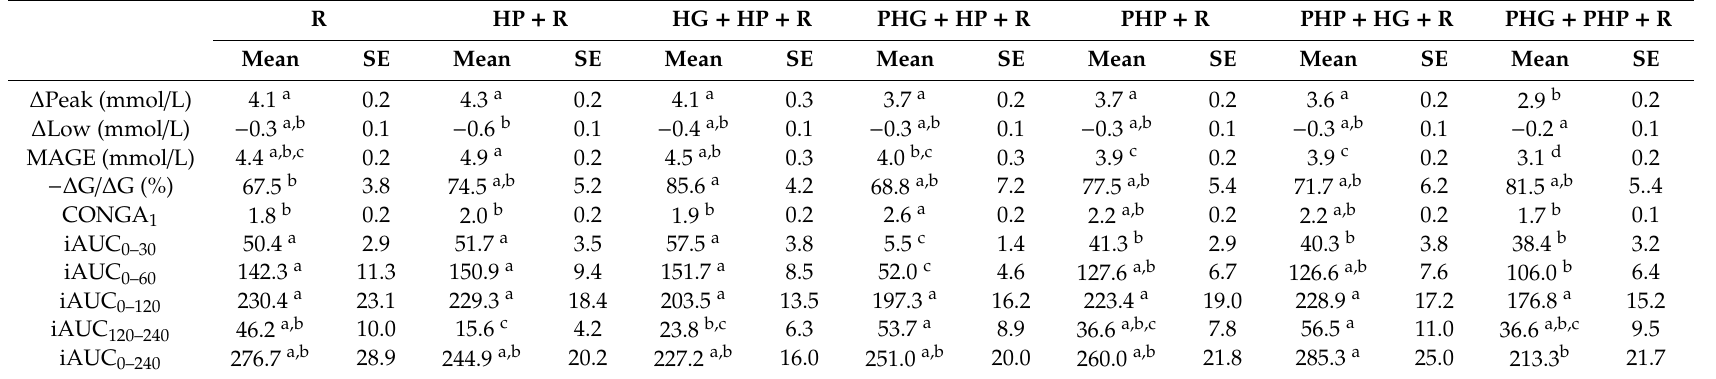
Table 3. Indices of glycemic variability for test meals in 240 min (mean values and standard errors (SE), n =